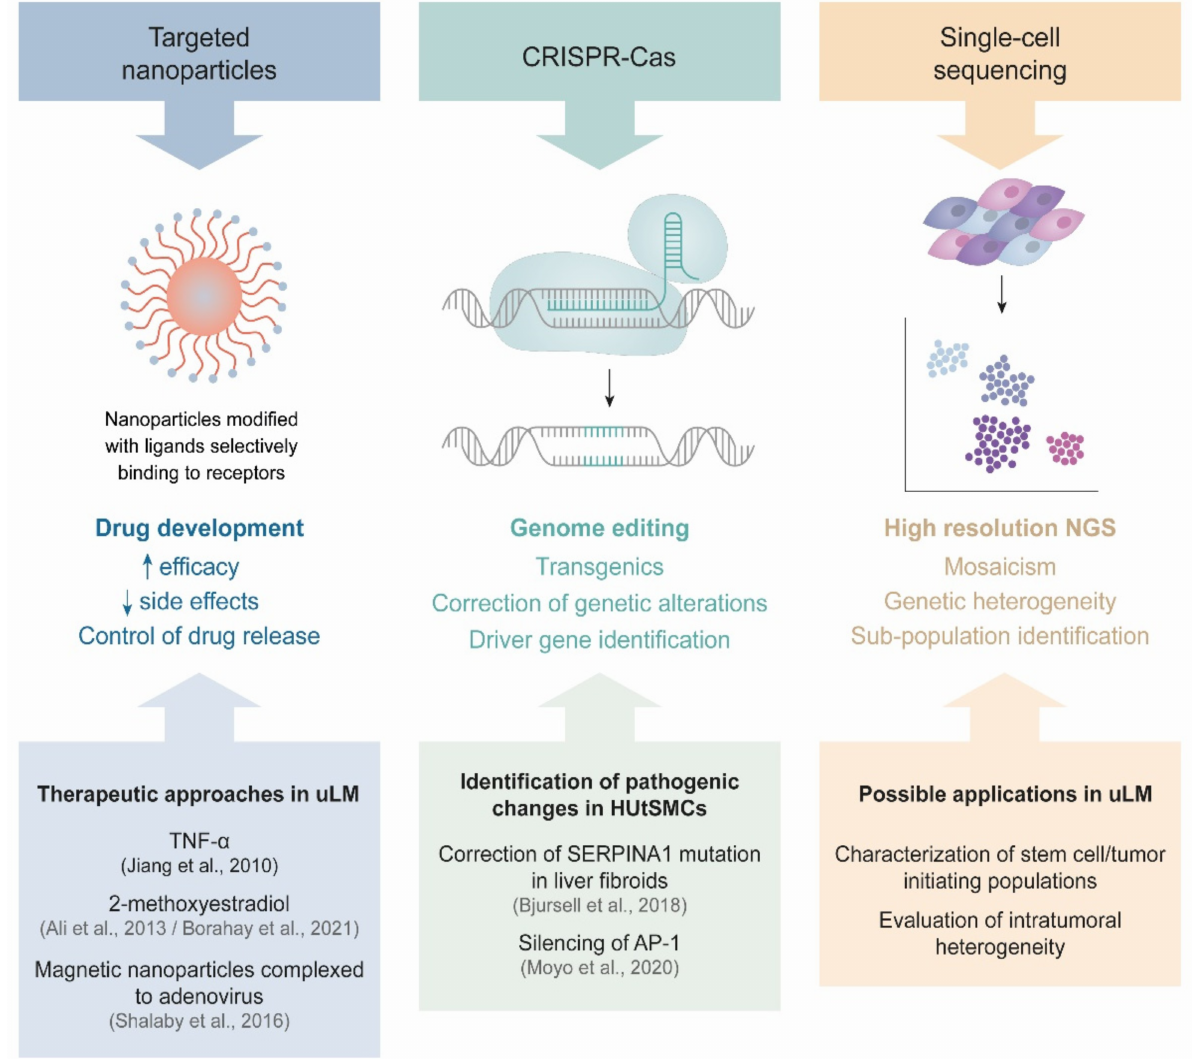
Figure 4. New techniques in uLM research. Each technique and its features are displayed, with relevant publications or future directions in uLM